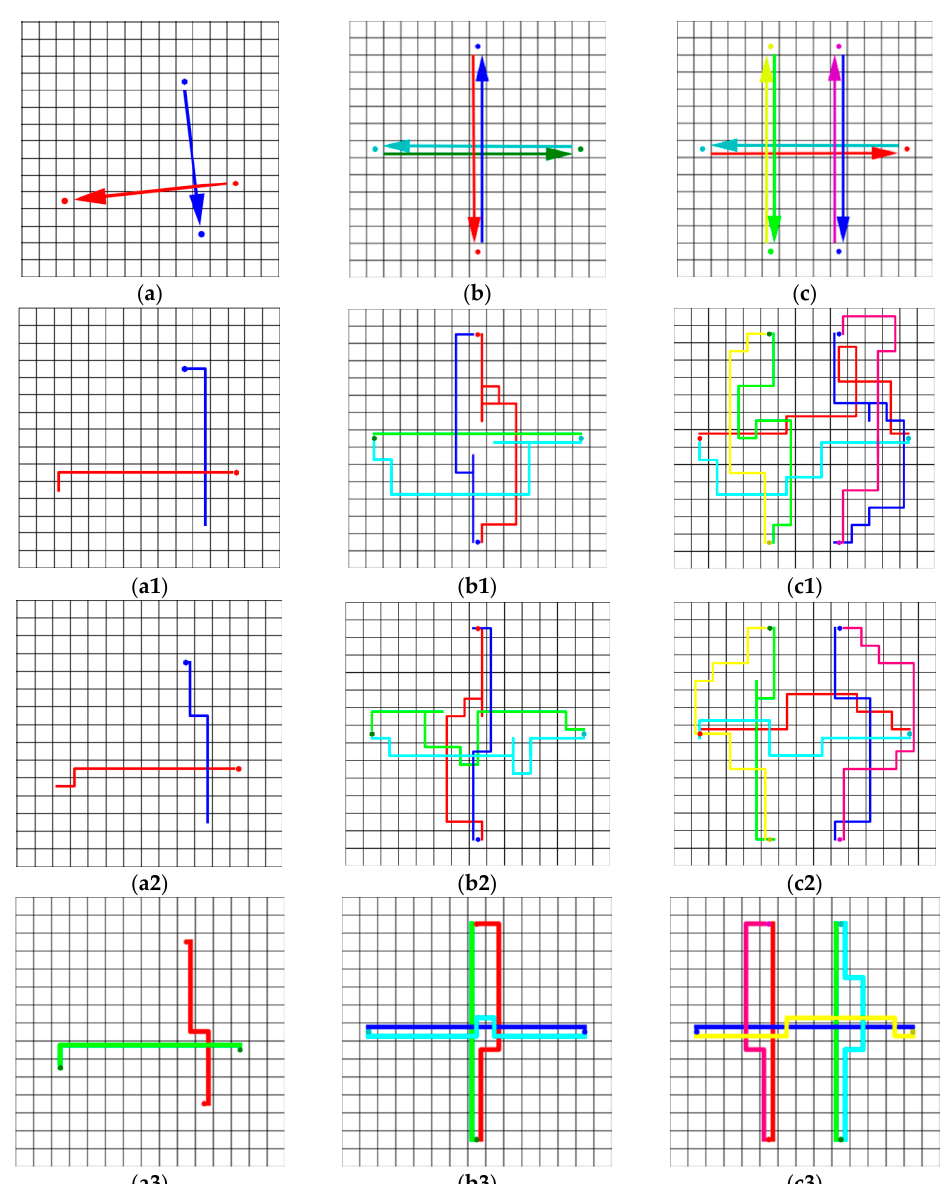
Figure 10. ( a – c ) Schematic diagrams of the start and end positions of the three cases. The position pointed to by the arrow is the end position of each robot. In cases ( b , c ), the robots gathered in the center. ( a1 – c1 ), ( a2 – c2 ), and ( a3 – c3 ) are the robot trajectories, which used different methods to guide the robot to complete the case, where hexagons mark the starts. The policies used in ( a1 – c1 ), ( a2 – c2 ), and ( a3 – c3 ) are Policy_1, Policy_2, and CBS